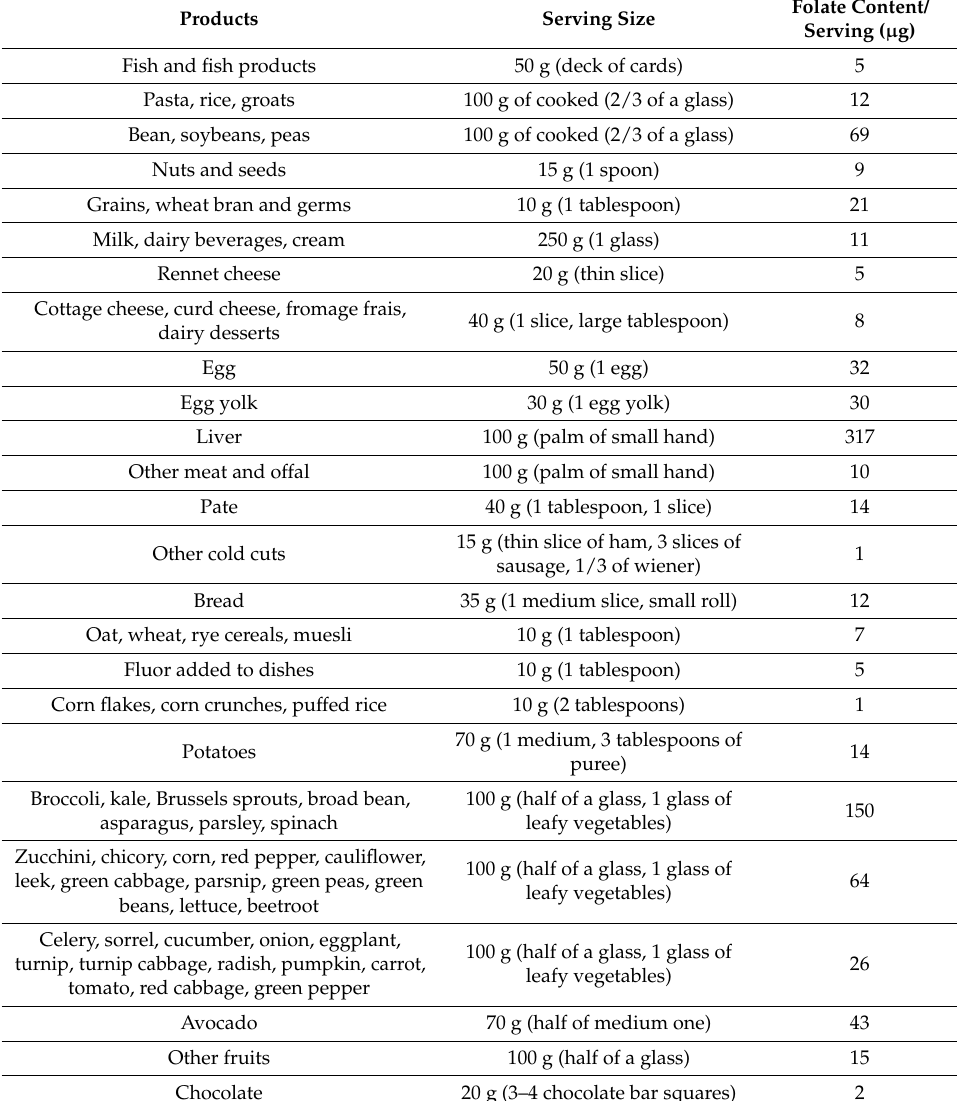
Table 2. The content of folate in one serving of a size specified in the